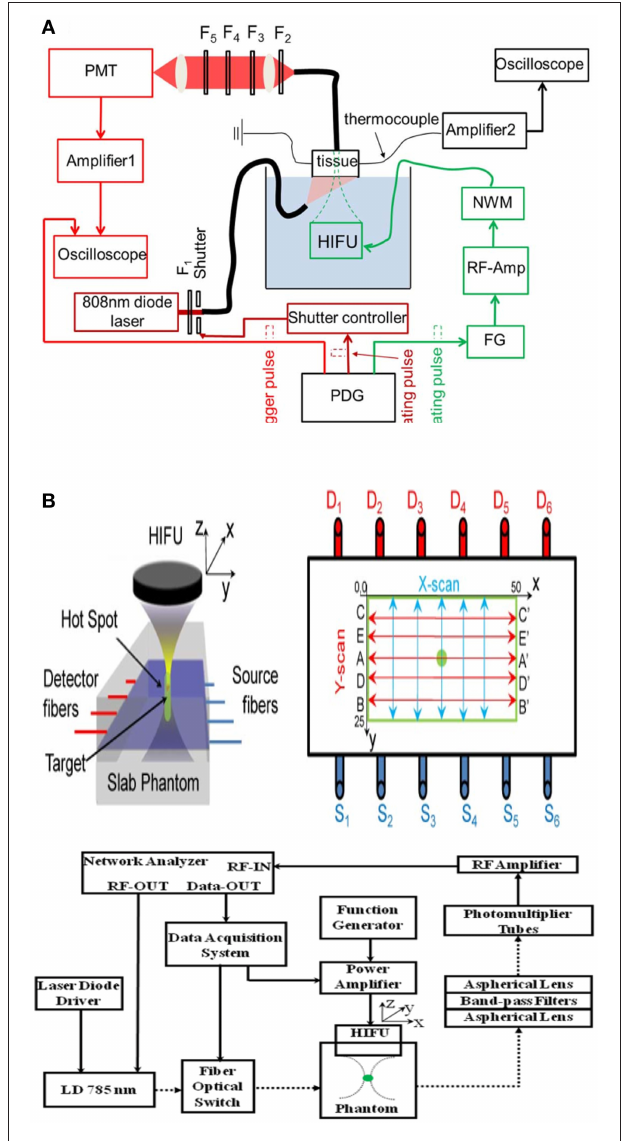
FIGURE 6 | Diagrams of two fluorescence intensity-based USF imaging systems, reported by two different research groups: (A) Yuan et al., 2012; Pei et al., 2014; and (B) Lin et al., 2012a. Reproduced with permission. Copyrights 2012 API Publish and 2014 © Springer Nature.